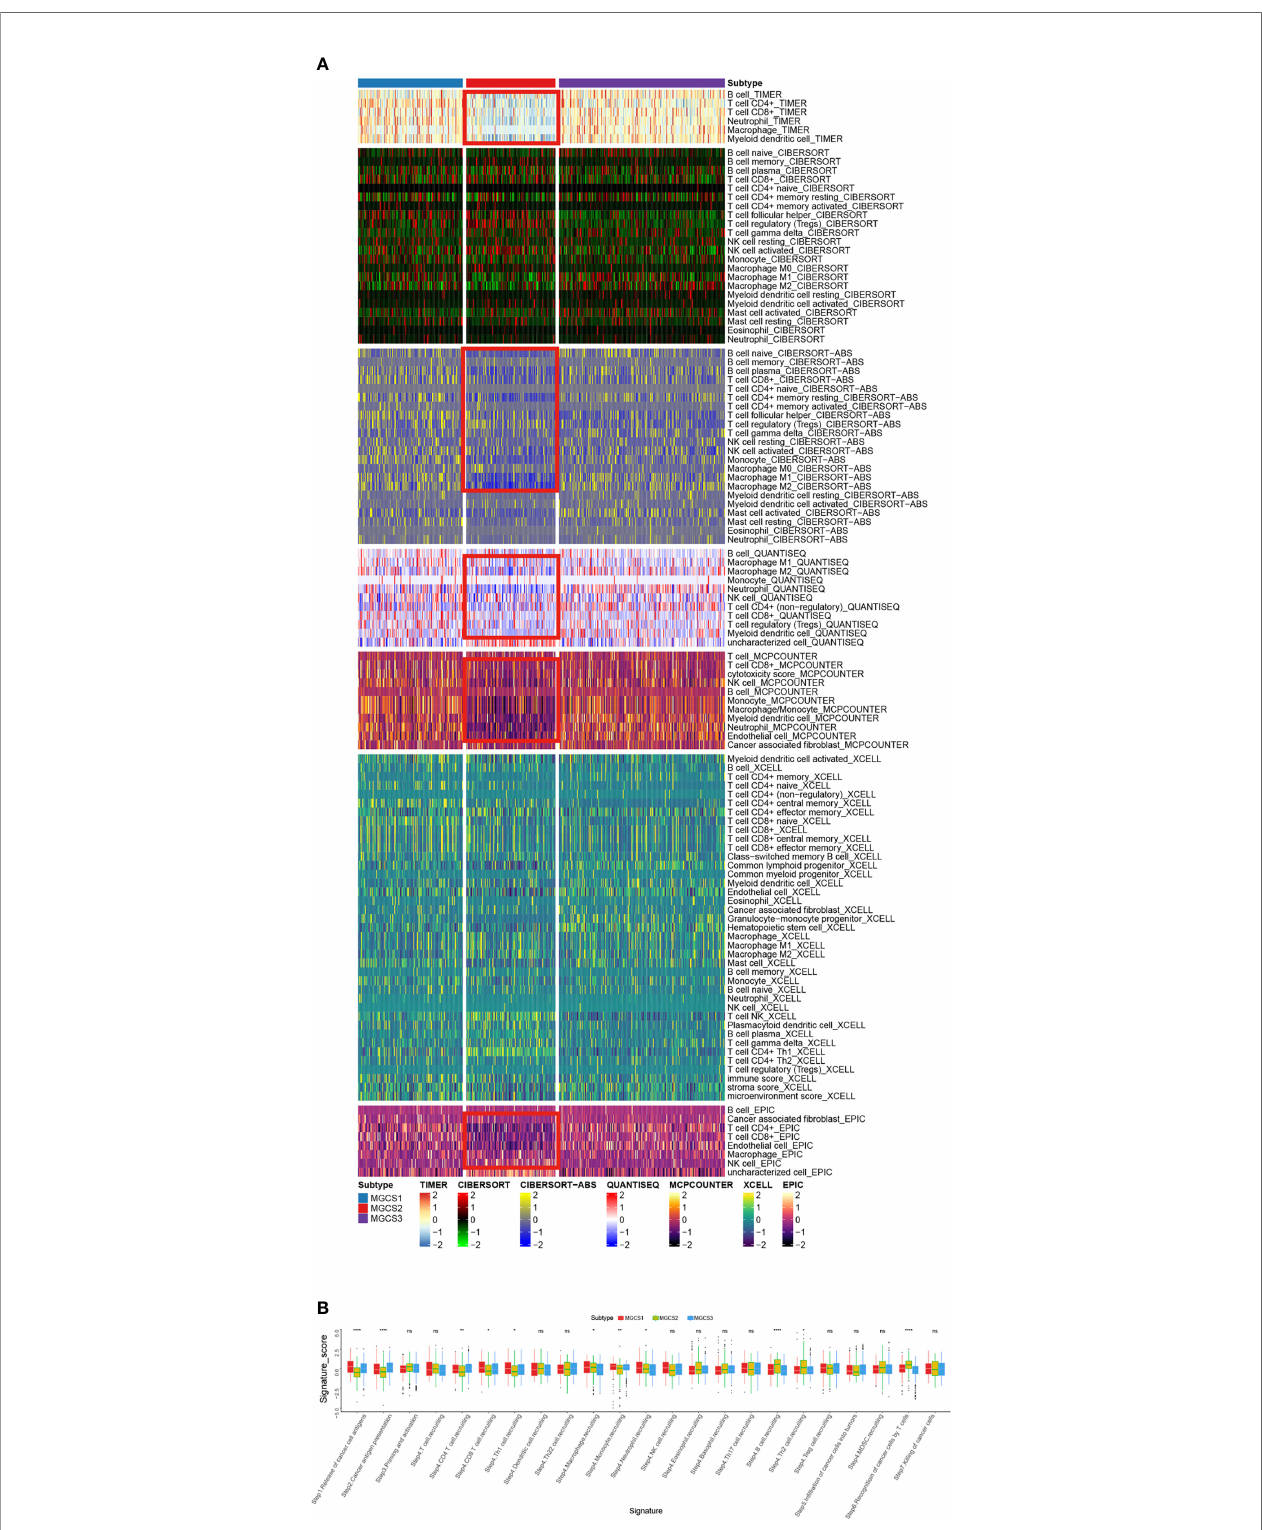
FIGURE 4 | Identi fi cation of immune landscapes. (A) Heatmap of tumor-related in fi ltrating immune cells based on TIMER, CIBERSORT, CIBERSORT-ABS, QUANTISEQ, MCPCOUNTER, XCELL, and EPIC algorithms in the three subtypes. (B) The difference in anti-cancer immune response among three subgroups. *P < 0.05; **P < 0.01; ****P < 0.0001; NS p >